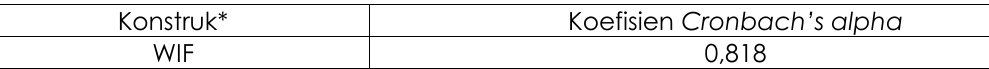
Tabel 4. Hasil Uji Reliabilitas untuk Setiap Konstruk